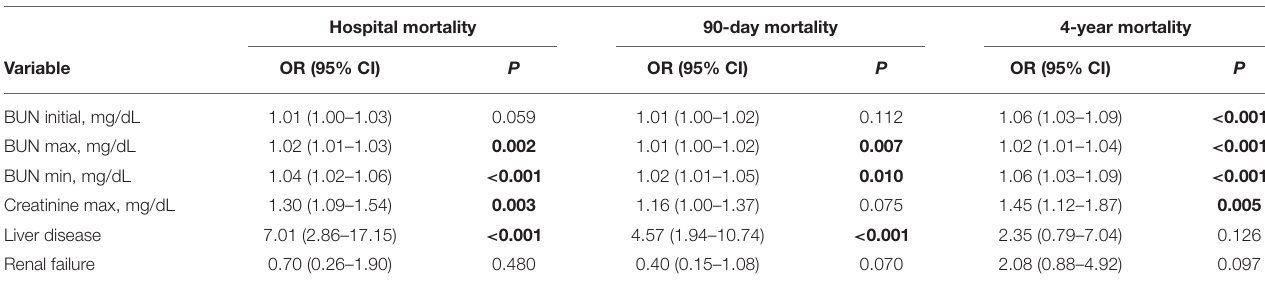
TABLE 6 | Univariate logistic regression analyses for prognosis in PPH patients. Hospital mortality 90-day